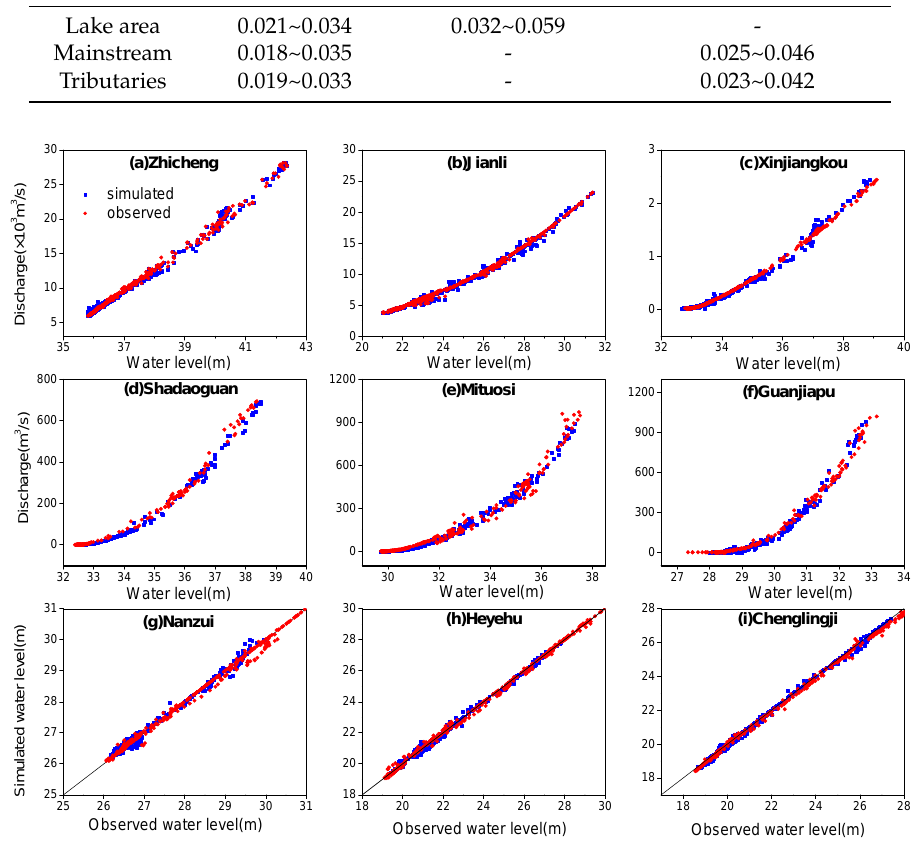
Figure 3. Model calibration results at the gauging stations in the river ‐ lake system.